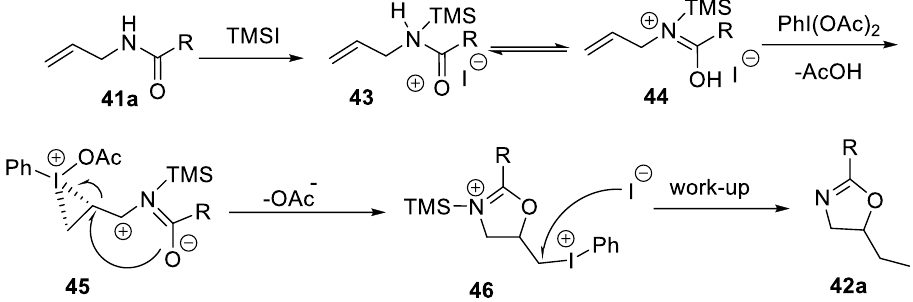
Figure 7. Proposed mechanism for the formation of 5-halomethyloxazolines/thiazolines.